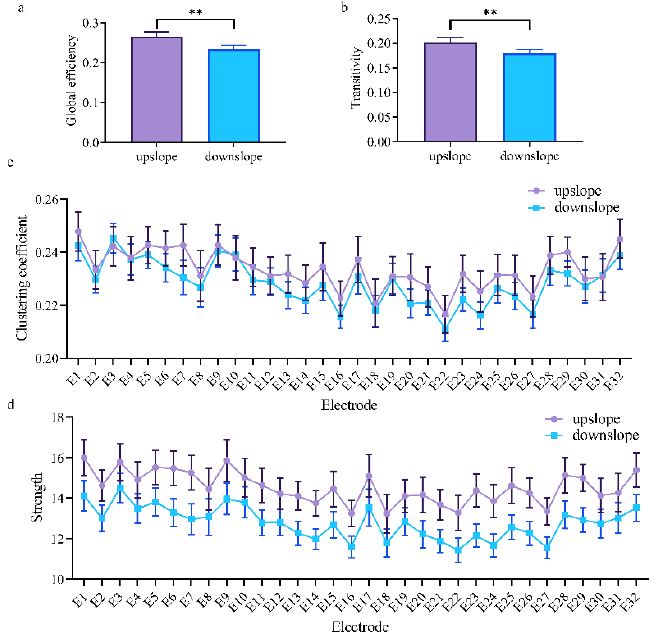
Figure 4. Indexes of the brain network for two locomotion states in the full-frequency band (7–100 Hz). ( a , b ) Global indexes of the brain network, including global efficiency and transitivity. ( c , d ) Local indexes of the brain network, including clustering coefficient and strength. All error bars indicate the 95% confidence interval of the mean. ** p ≤ 0.01.